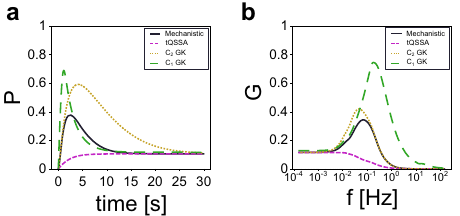
Fig. 10 Approximation comparisons. a Time courses for variable P obtained by using the mechanistic model (black solid), the tQSSA (orange dashed), and a combined mechanistic model with a Goldbeter – Koshland approximation for only one of the modi fi ed enzymes (purple and green). b Gain versus frequency plots for the same conditions as in a . Parameter values as in Fig.